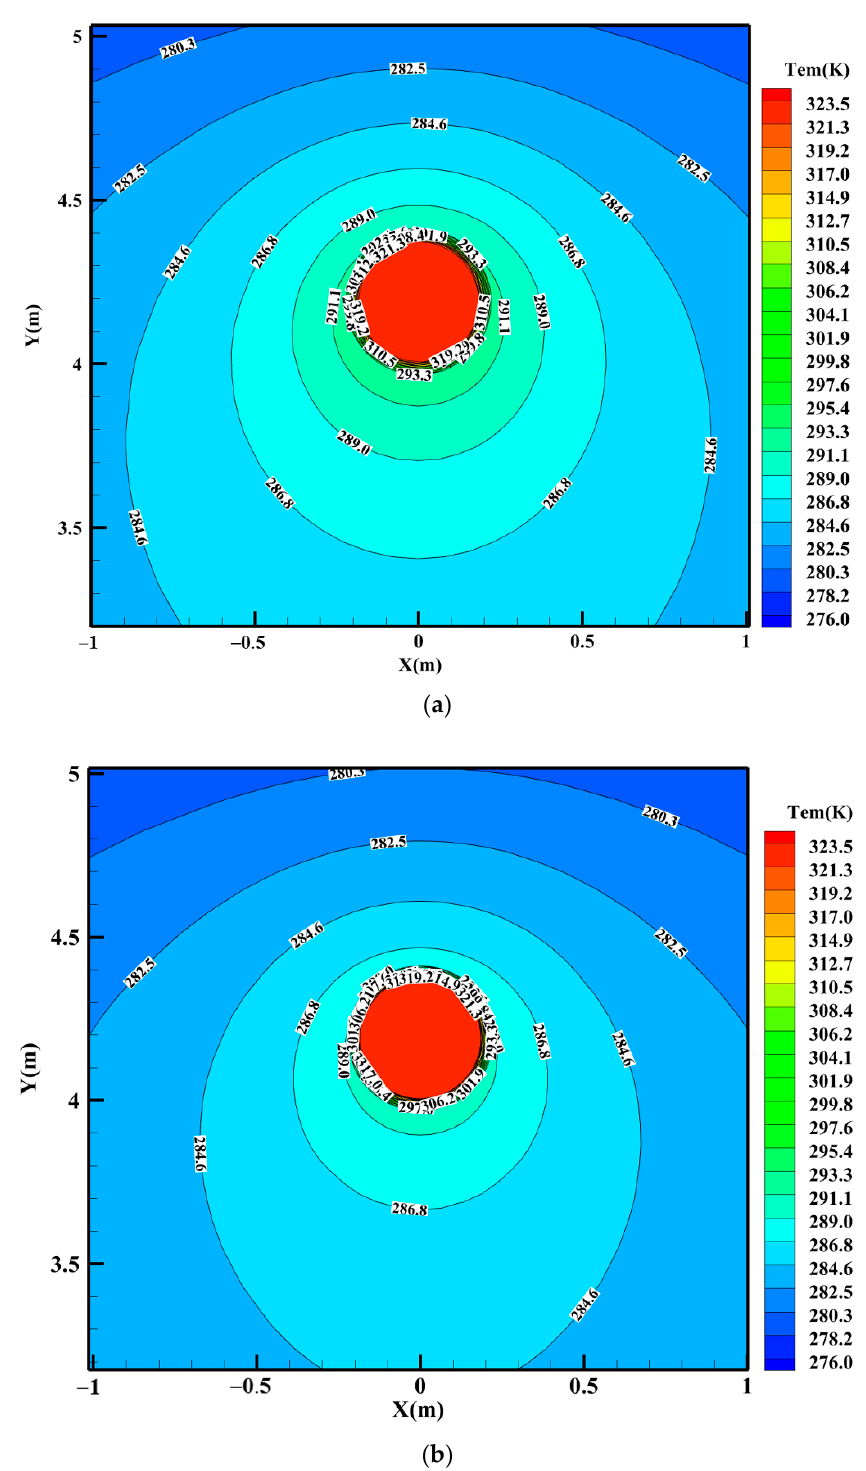
Figure 7. Temperature field on the cross section with different wax layer thickness. ( a ) with 0 mm wax layer. ( b ) with 4 mm wax layer. wax layer. ( b ) with 4 mm wax